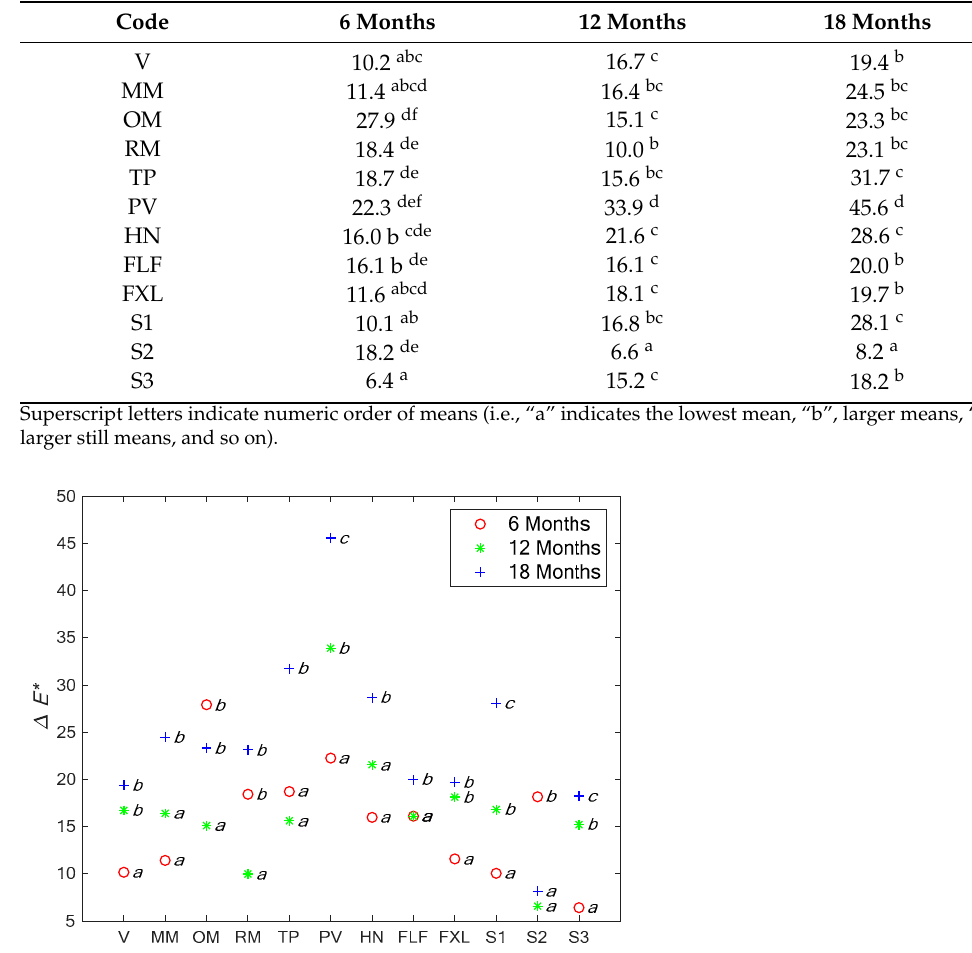
Table 3. Games–Howell pairwise mean differences of color change for Douglas-fir for each interval of the study. Letters in superscripts indicate means between treatment groups that are not significantly different at the p < 0.05 level.